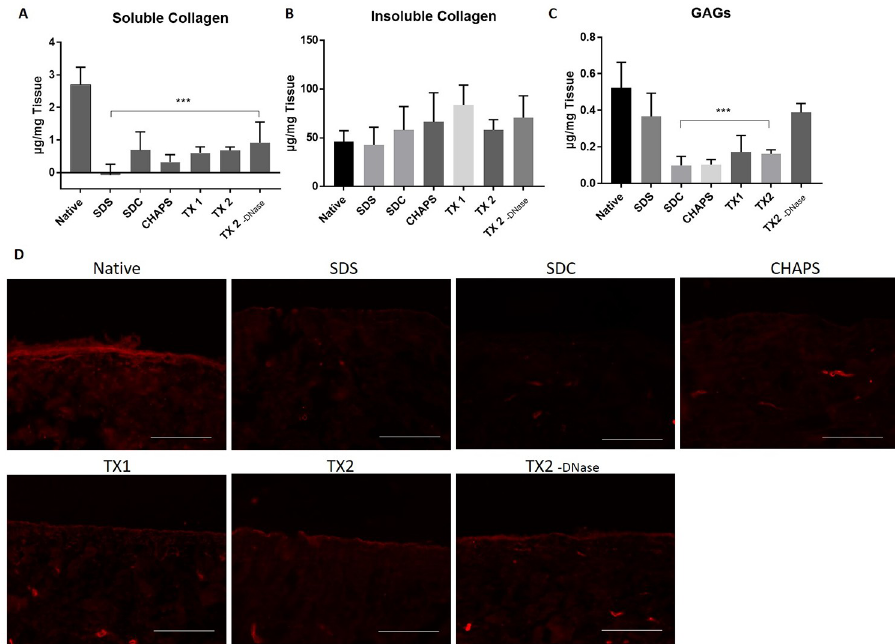
Fig 3. Quantification of the ECM proteins. Porcine vena cavas were decellularized according to the respective protocols and ECM proteins were analyzed using Biocolor assays and immunohistochemistry. (A) Quantification of soluble collagen. (B) Quantification of insoluble collagen. (C) Quantification of glycosaminoglycans (GAGs) (n = 3 in all groups). (D) Staining of paraffin-embedded sections with anti-laminin antibody. Scale bar represents 100 μ m.